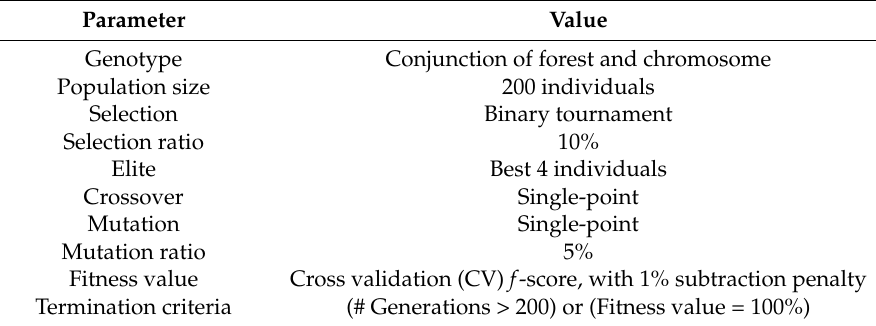
Table 7. Main parameters of the